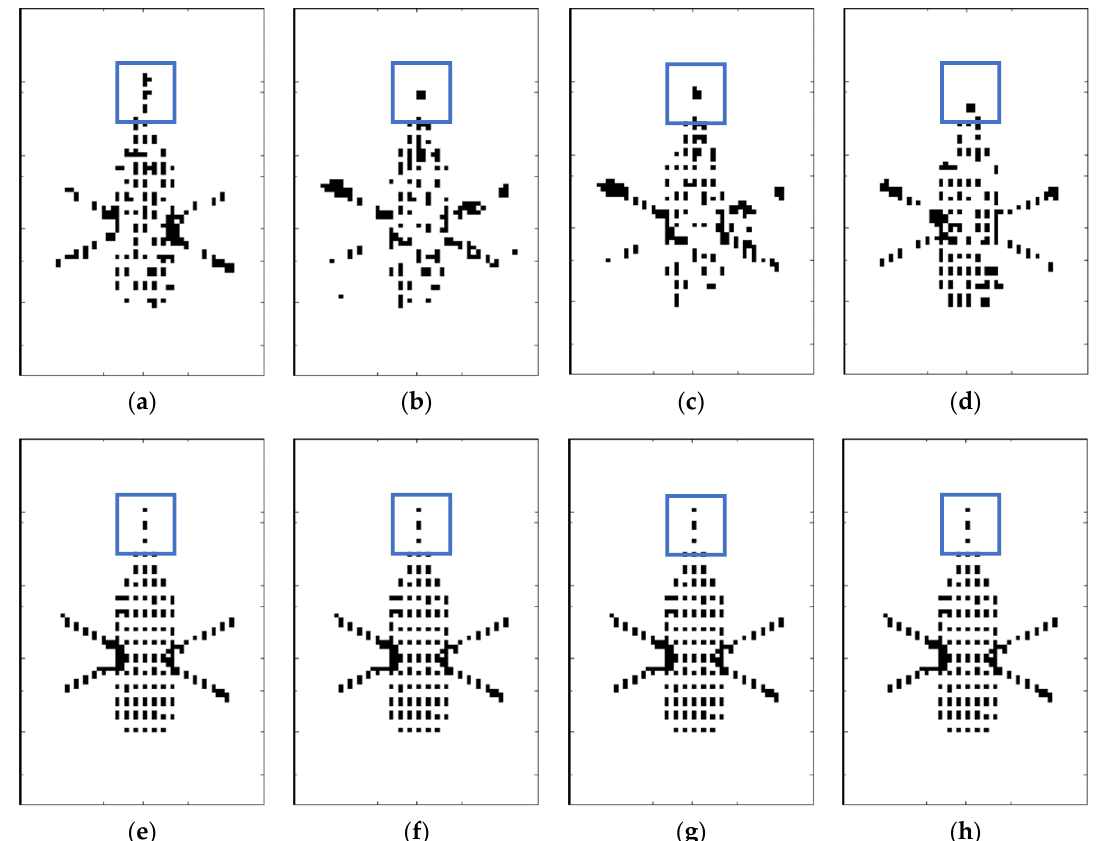
Figure 9. Mapping images of single-channel reconstruction and multichannel joint reconstruction: ( a–d ) represent the single-channel reconstruction images in HH, HV, VH and VV polarization channels, respectively; ( e–h ) represent the multichannel joint reconstruction images in HH, HV, VH and VV polarization channels, respectively. Notice that the blue boxes mark the scattering points at the same location in the different images. It is clear that the positions of the scattering points differ from each other when each polarization channel is reconstructed separately. In contrast, the positions of the scattering points from the joint reconstruction results remain consistent within each channel.